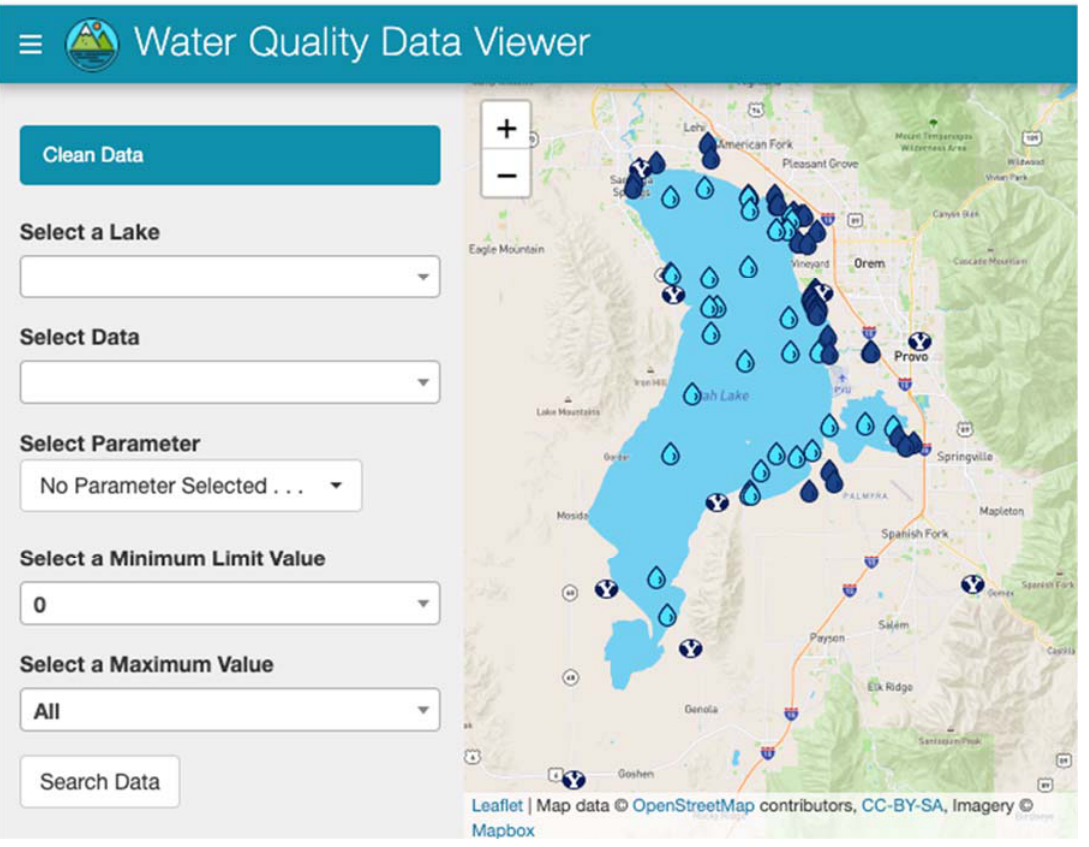
Figure 1. WQDV Home Page showing in-lake, out-of-lake, and BYU measurement locations as light blue, dark blue and “Y” icons, respectively.